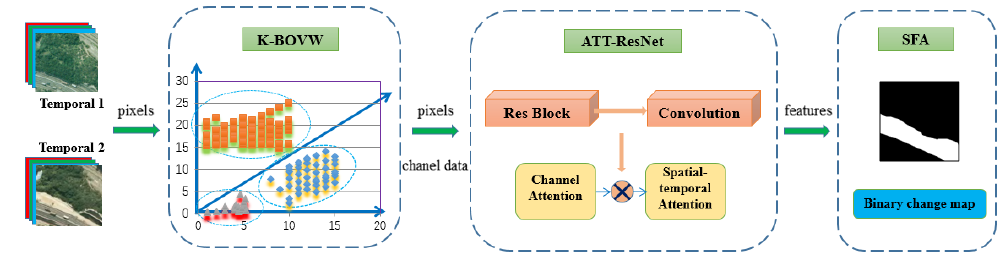
Figure 2. The schematic of multi-attention slow feature analysis. Algorithm 1 Flowchart of